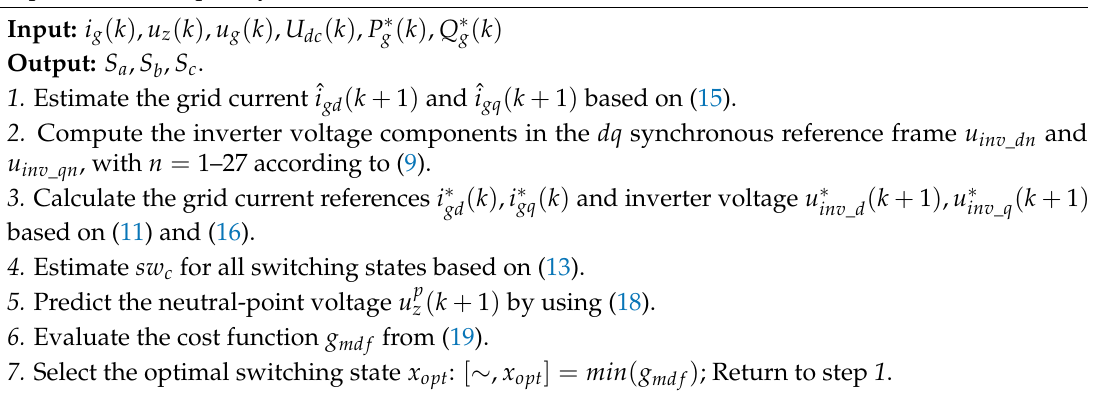
Algorithm 1 Algorithm of modified model predictive power control with reduced computational complexity.